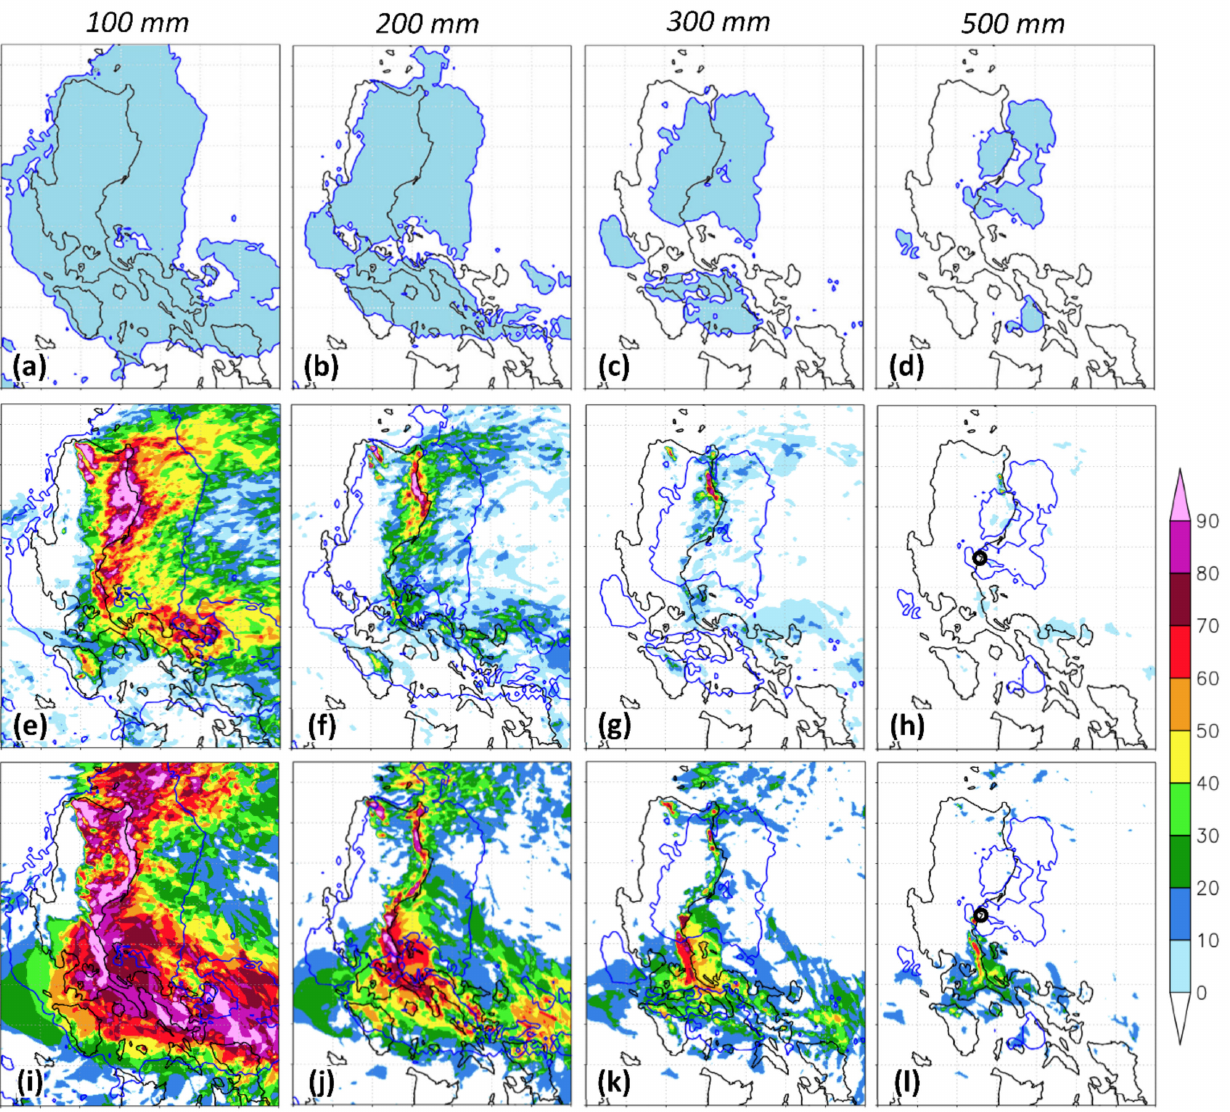
Figure 16. As in Figure 11, except for ( a – d ) areas reaching the four thresholds for the 72 h period of 14–16 December from TY Melor (2015) and probabilities (%) of QPFs from ( e – h ) the first 12 time- lagged members (with t 0 during 9–11 December) and ( i – l ) the last nine members (with t 0 during 12–14 December), respectively. The location of Baler is marked with an open circle in ( h , l ). At 300 mm, the GPM (Figure 16c) still indicated a large area to meet this criterion, approximately 100 km both onshore and offshore of eastern Luzon from 15 ◦ N to 18 ◦ N, the ocean surrounded by southern Luzon and Mindoro, and an area west of Manila Bay, where Melor stalled. Except along a short segment of the SSM, the probabilities in the first 12 runs to reach 300 mm were all too low (Figure 16g). Again, the values were improved along the storm track and the SSM in the later members, including the area near Baler (Figure